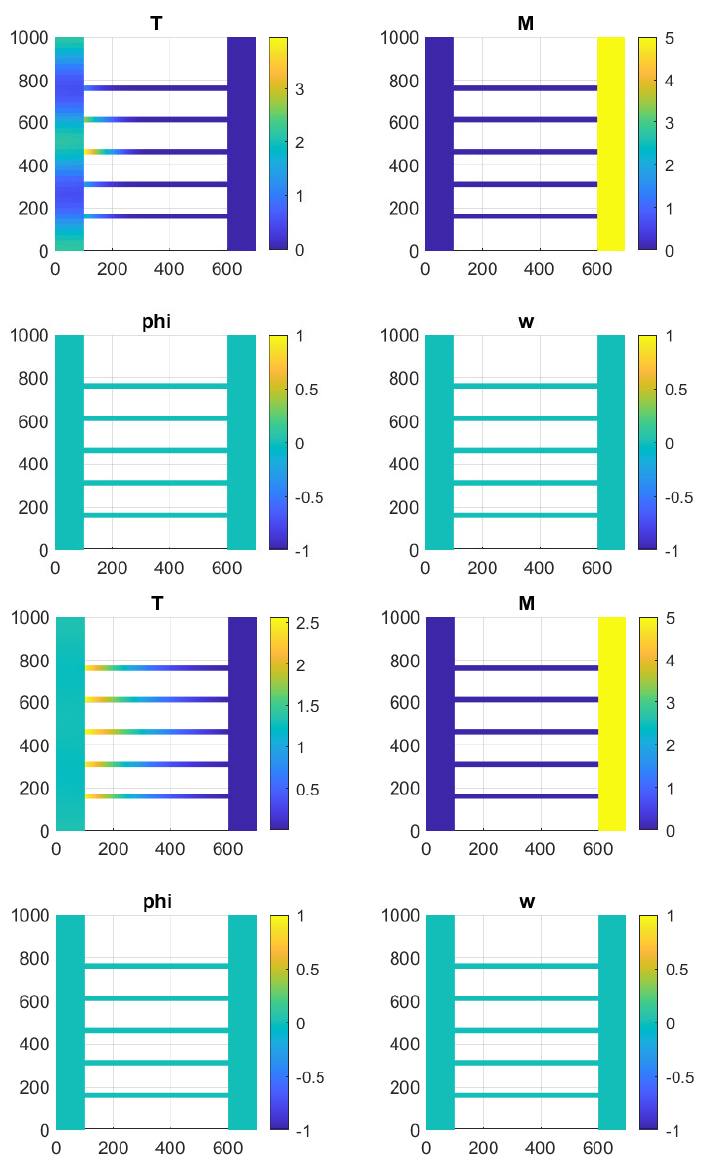
Figure 10. Untreated case. Evolution of the model (3)–(7) at time t = 10,000 s ( top ) and at time t = 50,000 s ( bottom